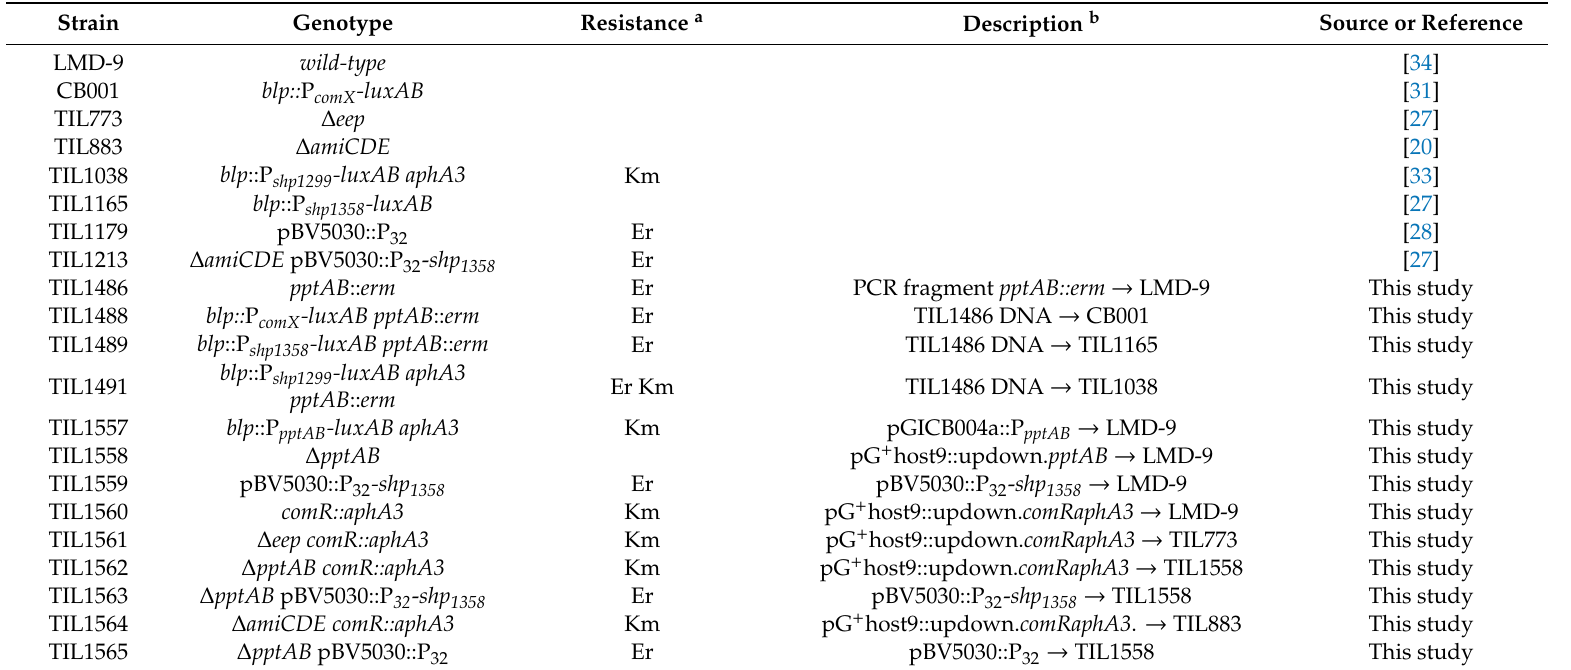
Table 1. S. thermophilus strains used in this